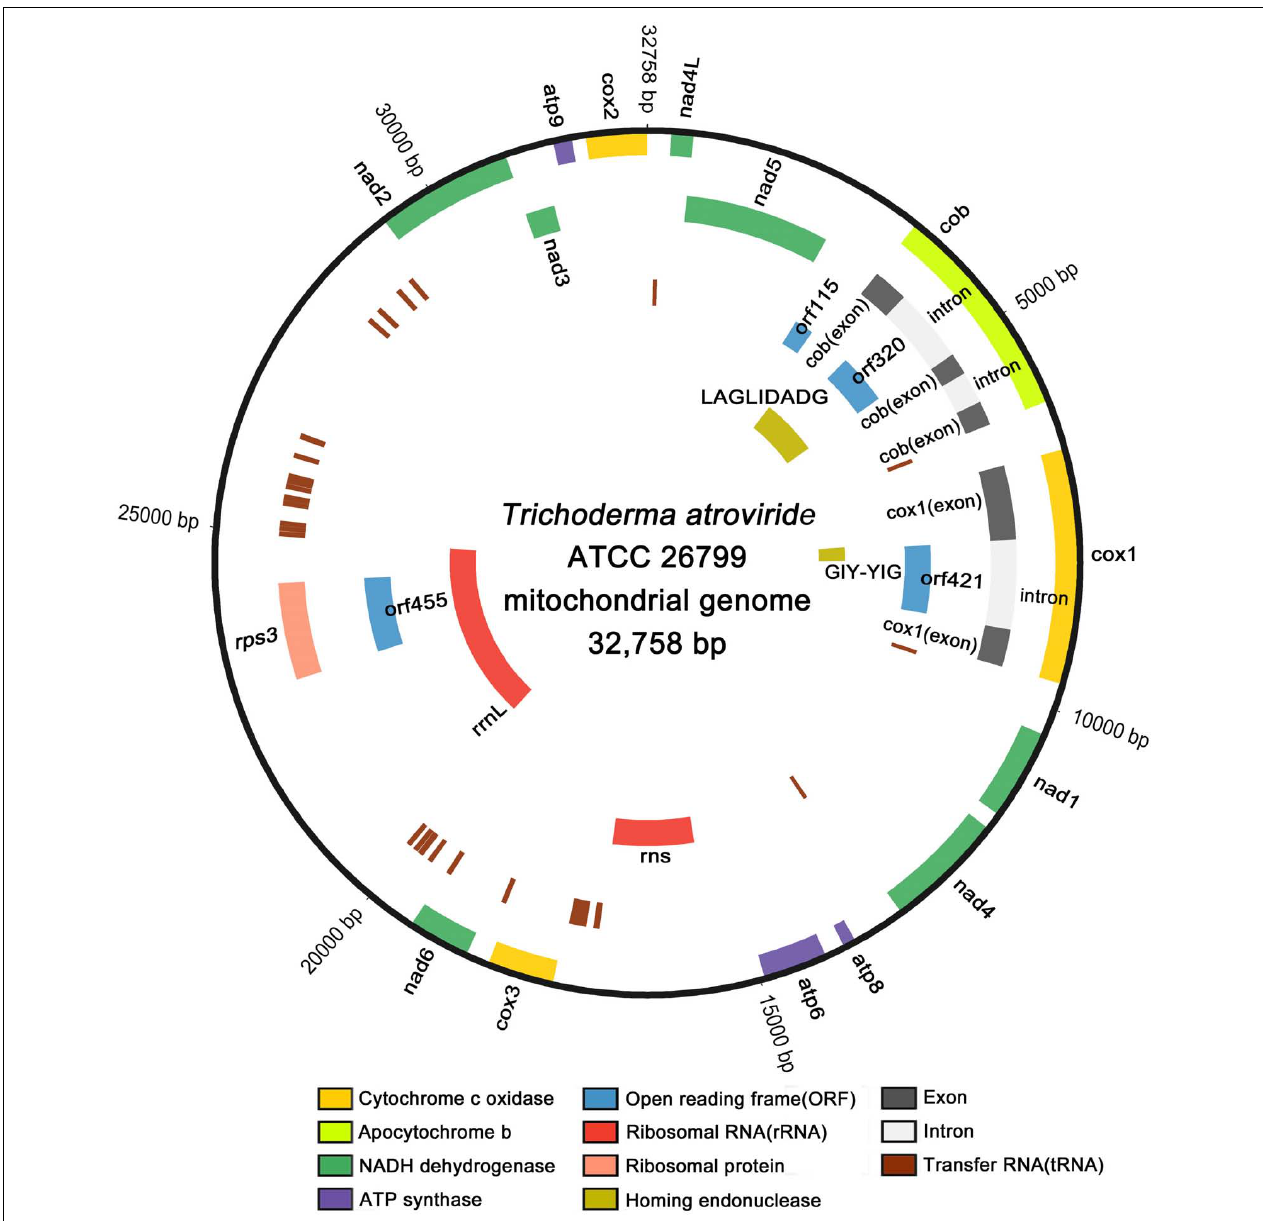
FIGURE 1 | Circular map of the complete mitochondrial genome of T. atroviride ATCC 26799. All genes are located on the heavy strand (H-strand) and transcribed in the clockwise direction, except for one gene encoding the GIY-YIG-type homing endonuclease that located on the light strand (L-strand) and transcribed in the anticlockwise direction. Gene components were indicated with different color blocks, and the circular map was plotted using Circos.